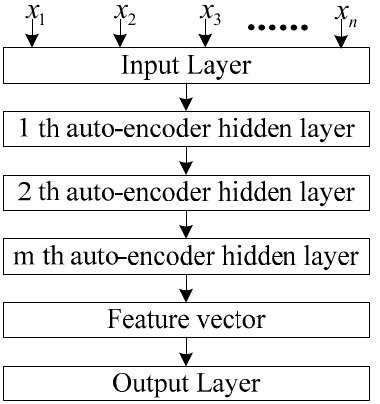
Figure 2. Stacked Autoencoder Neural Network.